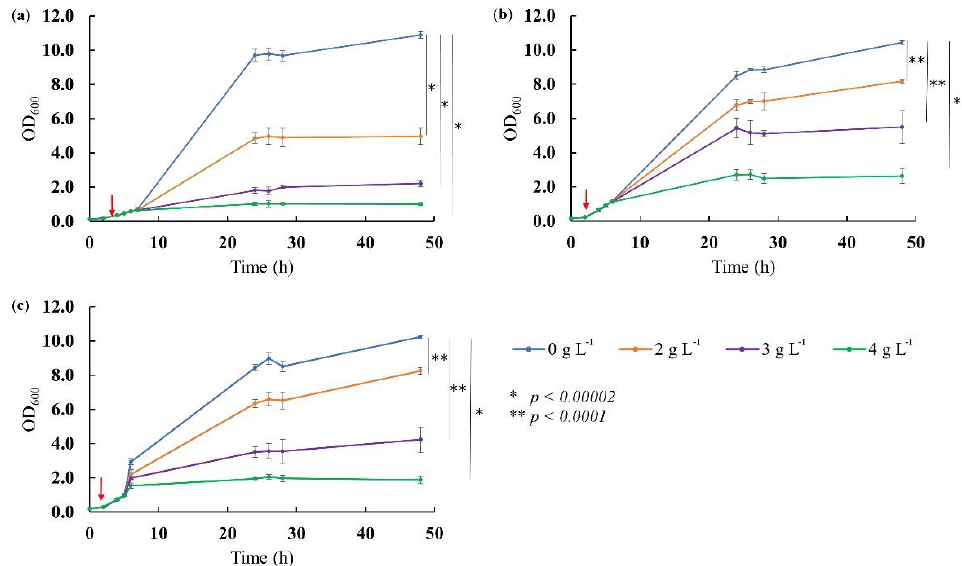
Figure 1. Effect of the presence of exogenous 2-PE on the growth of ( a ) K. lactis WUT175, ( b ) K. marxianus WUT216, and ( c ) K. marxianus WUT240. For each strain, four 48 h batch cultures in SAB were conducted. When the cultures reached OD 600 values of 0.6–0.8 (indicated by a red arrow), 2-PE was added to three cultures to final concentrations of 2, 3, and 4 g L −1 , respectively. The fourth culture was not supplemented with 2-PE and served as a control. Analyses were performed in triplicate and data are presented as the mean ± SD. Statistical significance between values is marked with asterisks.